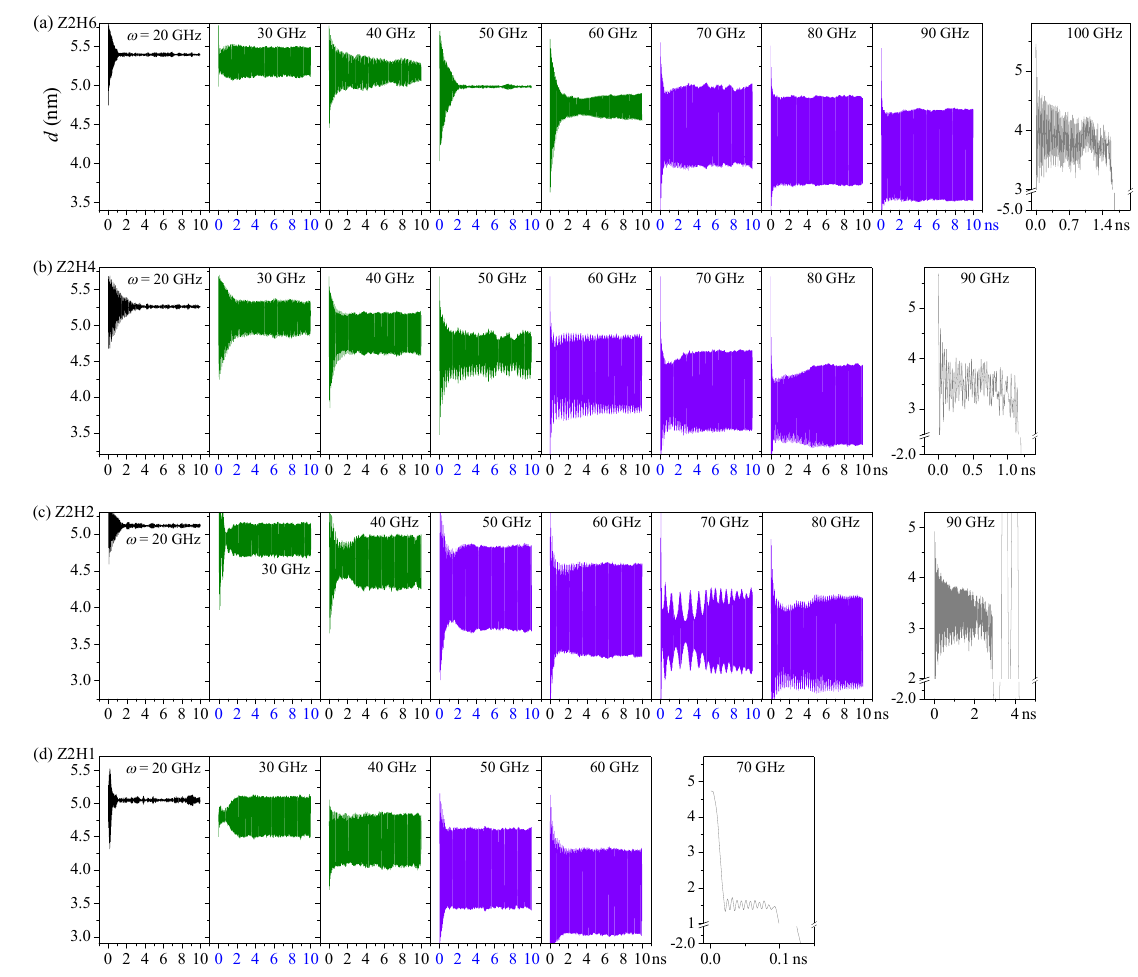
Figure 6. Axial motion ( d ) of the R-rotor with different hydrogenation schemes on the HDP with different rotational frequencies at 8 K: ( a ) Z2H6, ( b ) Z2H4, ( c ) Z2H2, and ( d ) Z2H1. In the Z2H2 system with ω = 70 GHz, the “beat” phenomenon happened in the first 5 ns.